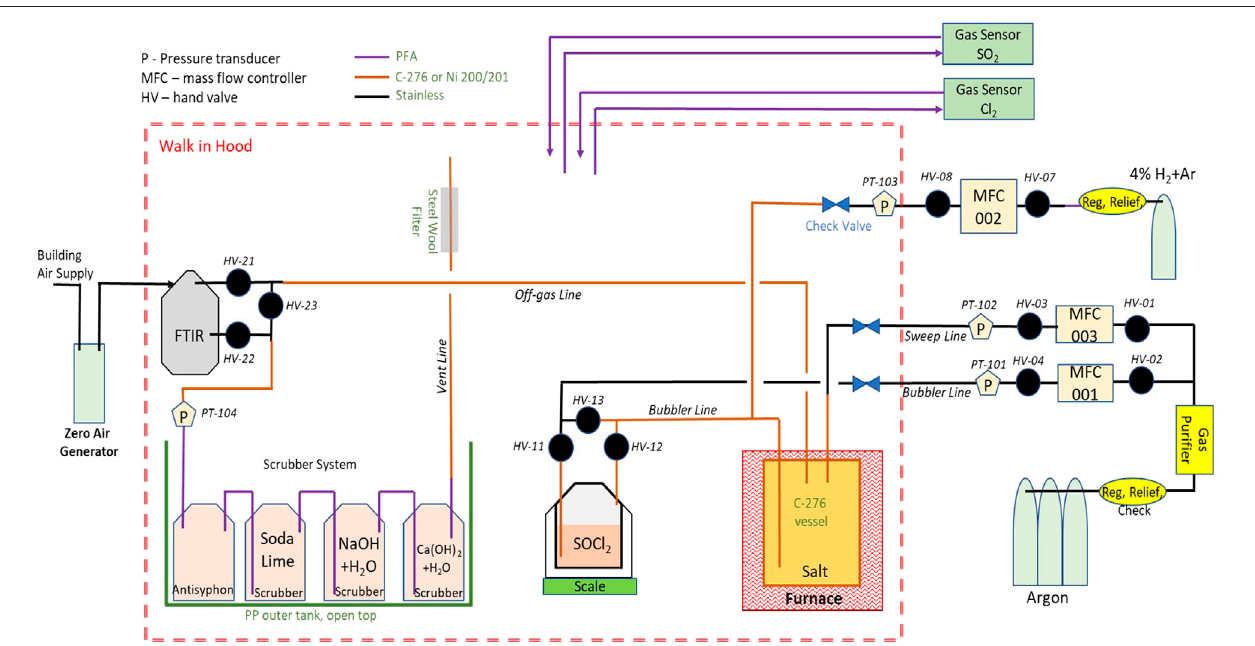
FIGURE 2 | Schematic of the apparatus used for thionyl chloride puri fi cation of chloride salt. Shown in the fi gure are the vessels holding the salt and the thionyl chloride reagent at the bottom center, gas handling at the right on the outside of the walk-in hood (the dashed red line), post-reaction analysis of the off-gas by FTIR on the left hand side of the fi gure, and the four-part scrubber gas system (lower left).